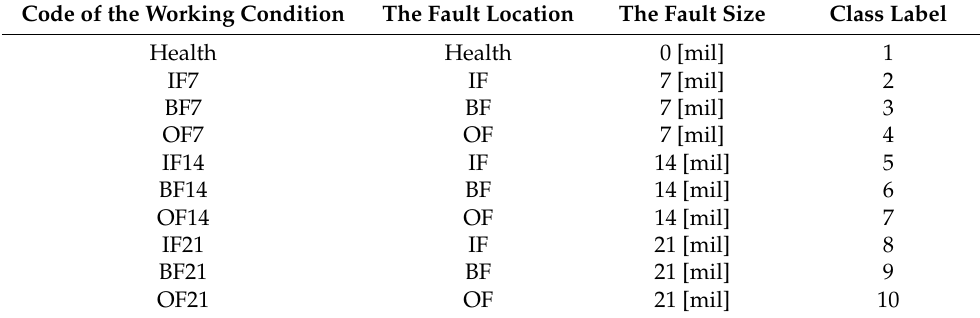
Table 3. Test fault setting.